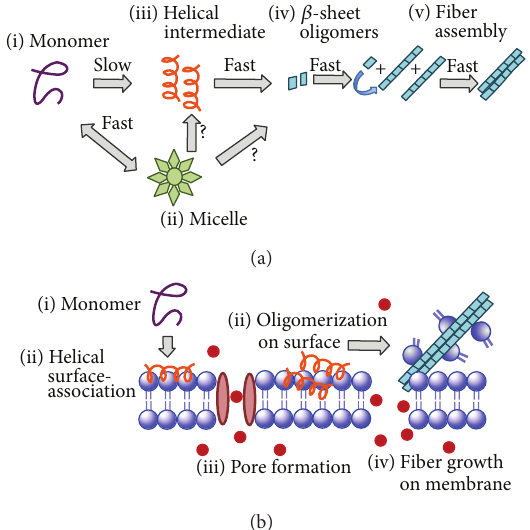
Figure1:SimplifiedrepresentationofhIAPPaggregationinsolution (a) and on the membrane (b). In solution (a), hIAPP initially exists in most experiments as a monomeric peptide (i) in exchange with a micelle-like form (ii). Transient helical (iii) and 𝛽 -sheet (iv) intermediates have been proposed but the exact nature and order of these species in the aggregation process are not clear. Once the nucleus for aggregation is formed, the final steps of the aggregation process are the elongation of the fiber by the addition of monomers (orpossibly 𝛽 -sheetoligomers)totheendsofthefiberandthelateral association of individual fiber strands (protofilaments) to form the amyloid fiber (v). On the membrane (b), monomeric hIAPP (i) can bind the membrane (ii) and self-associate on the membrane to form pores (iii) or helical structures (iv) that eventually form membrane- associated amyloid fibers (iv). During the fiber formation process (iv),lipidscanbeincorporatedintothehydrophobicendsofthefiber which would be otherwise exposed to water, causing disruption of the membrane